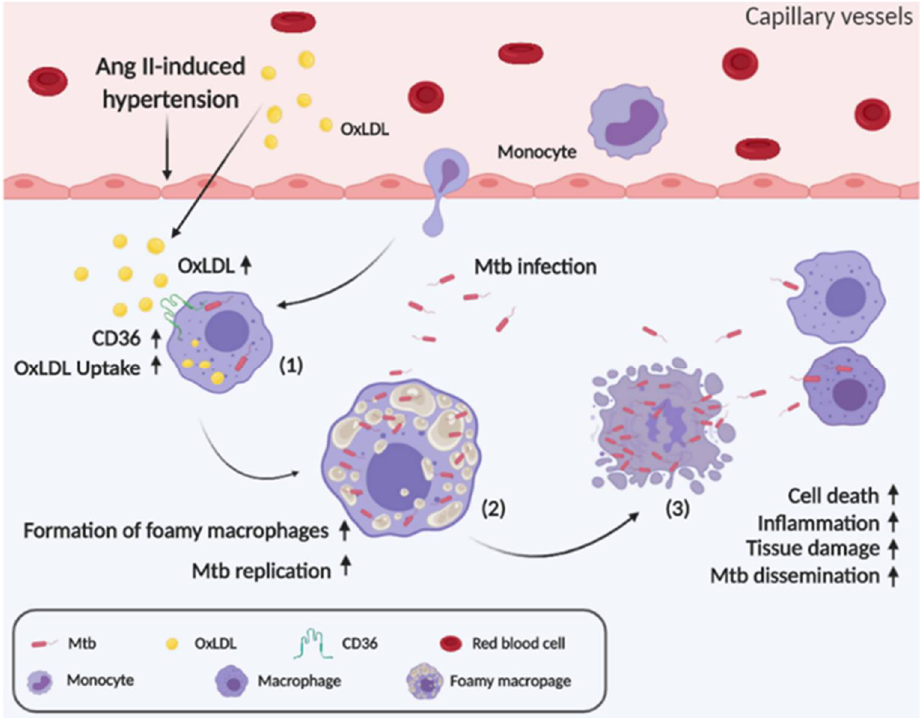
Figure 7. Schematic diagram illustrating the role of Ang II-induced hypertension during Mtb infection. (1) Ang II-induced hypertension increases CD36 expression on the surface of macrophages. CD36 expression is required for the accumulation of OxLDL in Mtb infected macrophages. (2) Lipid-loaded macrophages facilitate the replication of Mtb. (3) Formation of foamy macrophages promotes increased cell death and tissue damage, leading to dissemination of Mtb.